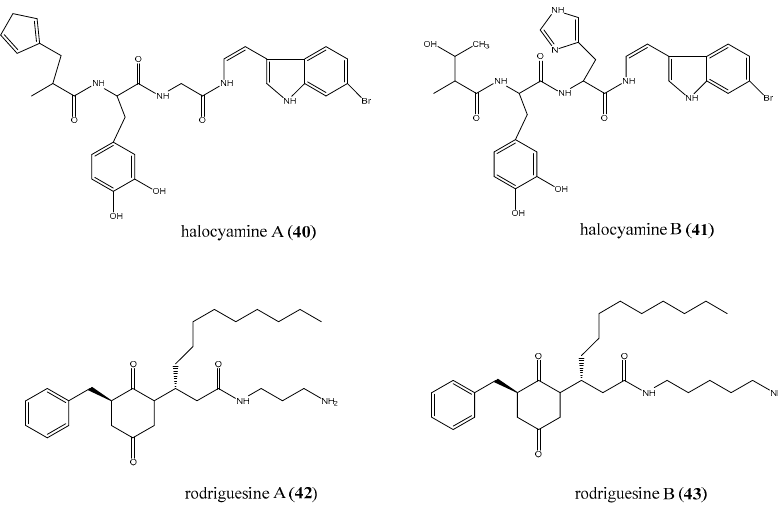
Figure 7. Structures of the peptide-like compounds halocyamines ( 40 and 41 ), and of rodriguesines A and B ( 42 and 43 ).